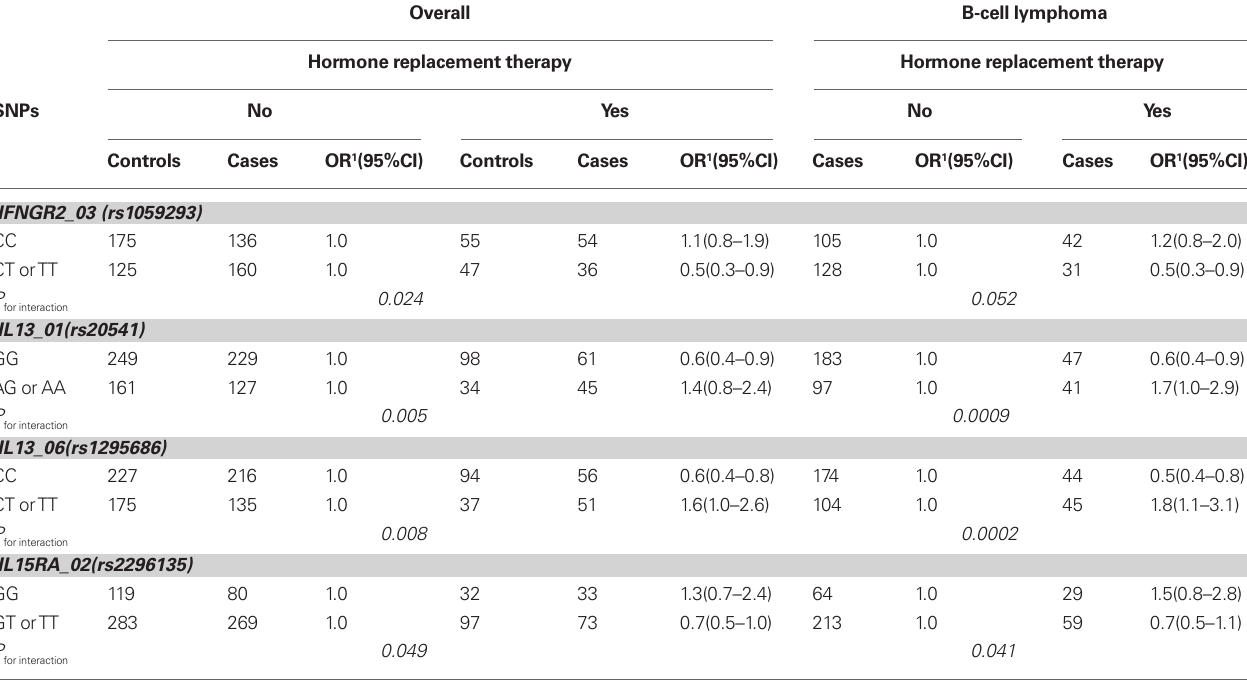
Table 2 | Associations between Th1/Th2 cytokine polymorphisms, hormone replacement therapy, and risk of non-Hodgkin